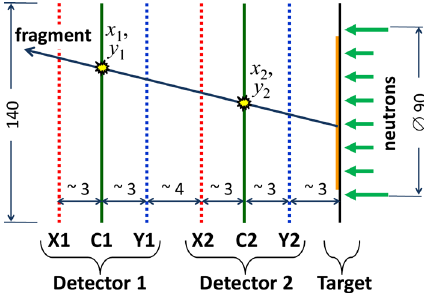
Figure 1. Scheme of the experimental setup (see text).